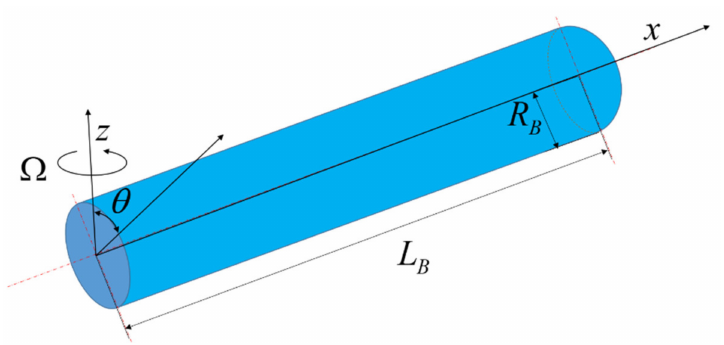
Figure 1. Model and coordinate